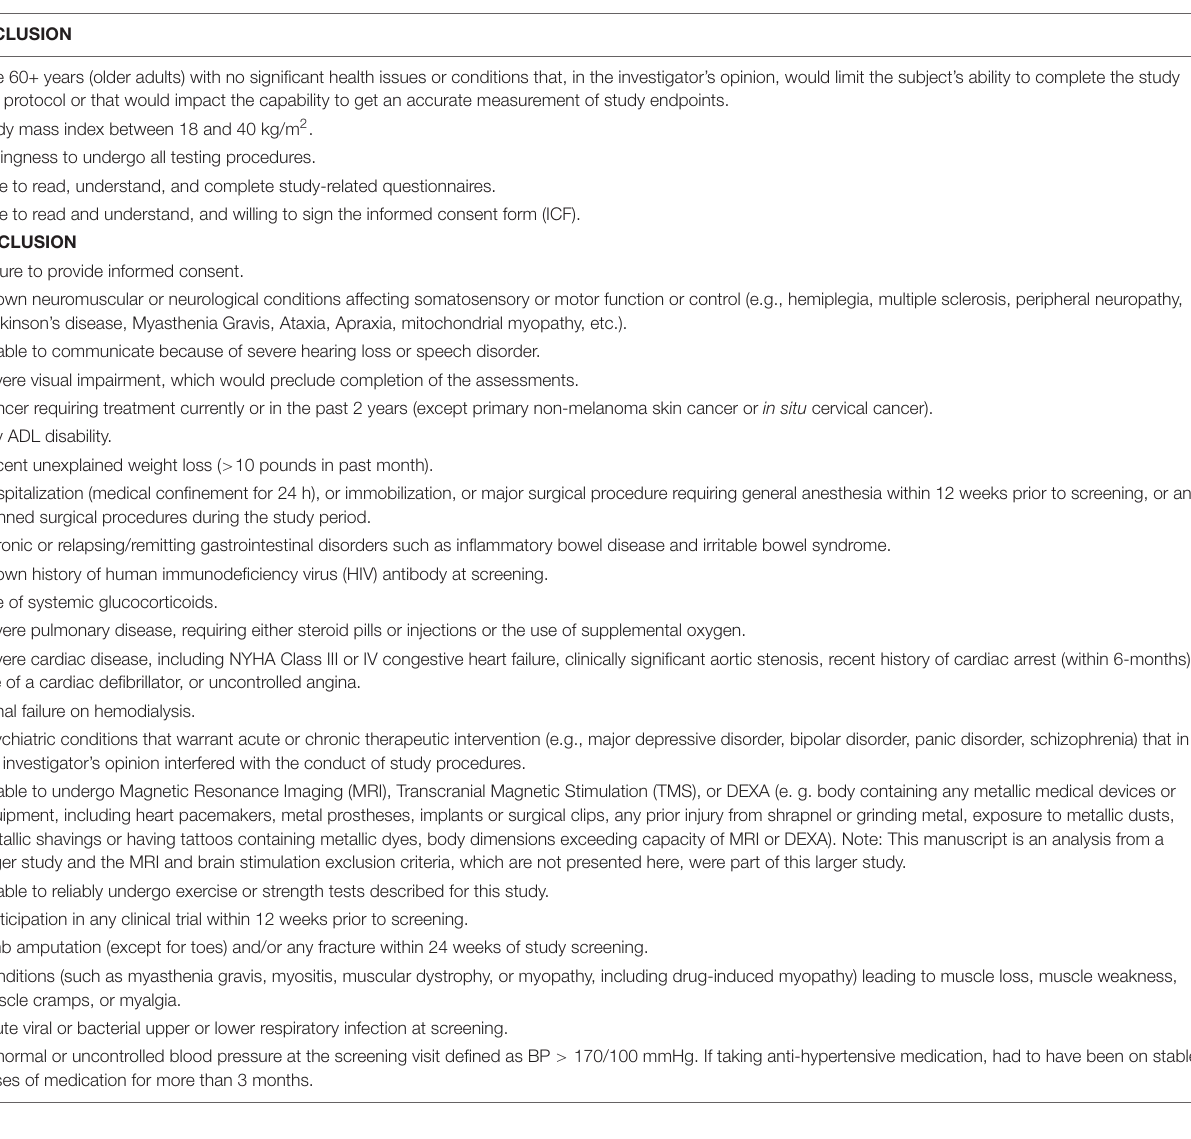
TABLE 1 | UNCODE inclusion and exclusion